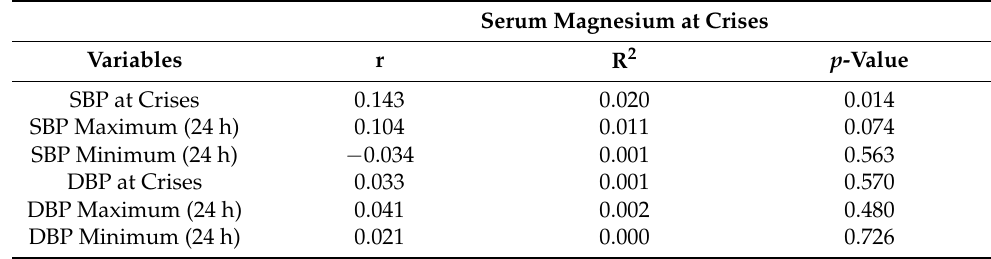
Table 6. Association of serum magnesium at crises with SBP and DBP at different time points ( N =